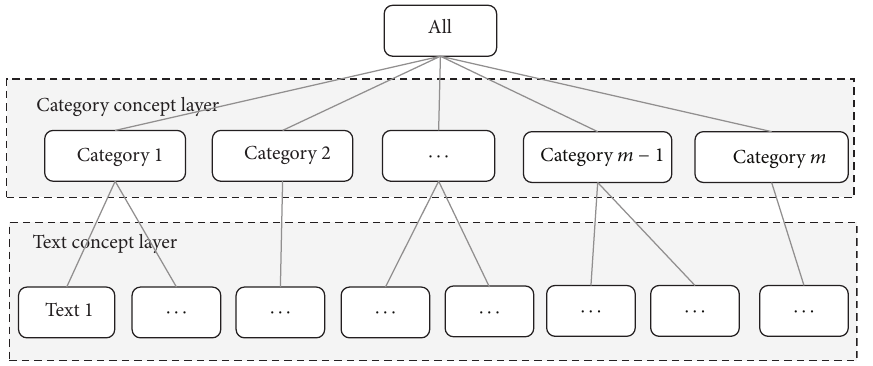
Figure 3: Pan-concept-tree for text classification.